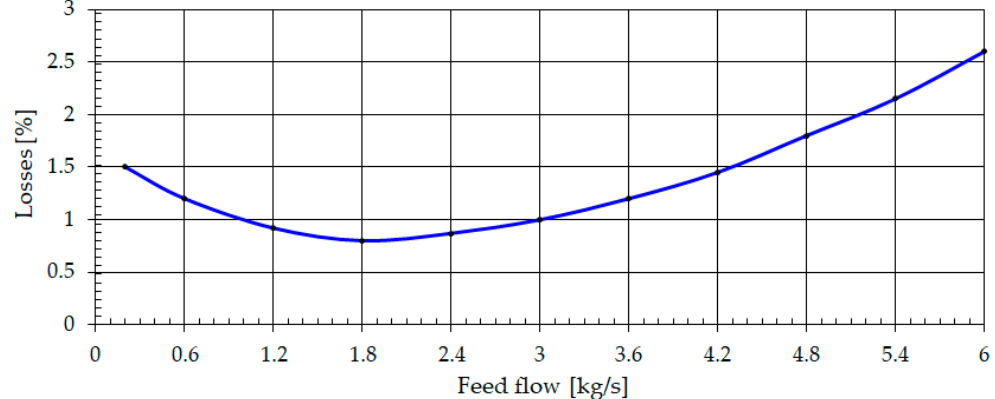
Figure 7. The variation in losses ( p ) depending on the feed flow ( Q ).